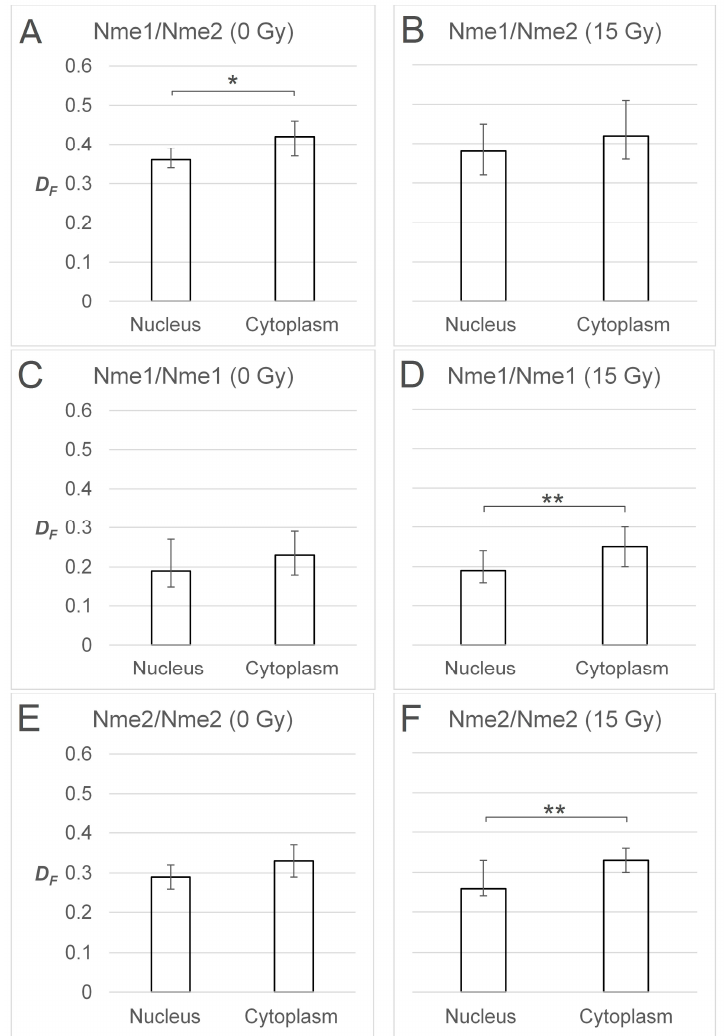
Figure 4. Comparison of D F between the nucleus and the cytoplasm in non-irradiated and irradiated cells expressing three pairs of fluorescently labeled NME proteins. Transfected cells were not irradiated (0 Gy) or irradiated with gamma radiation (15 Gy). ( A,B ) Comparison of D F between the nucleus and the cytoplasm in non ‐ irradiated ( A ) and irradiated ( B ) cells expressing EGFP ‐ NME1 and mCherry ‐ NME2. ( C,D ) Comparison of D F between the nucleus and the cytoplasm in non ‐ irradiated ( C ) and irradiated ( D ) cells expressing EGFP ‐ NME1 and mCherry ‐ NME1. ( E,F ) Comparison of D F between the nucleus and the cytoplasm in non ‐ irradiated ( E ) and irradiated ( F ) cells expressing EGFP ‐ NME2 and mCherry ‐ NME2. D F is shown as the median and the interquartile range. Statistical analysis shows that differences of D F between the nucleus and the cytoplasm ( A,D,F ) are statistically significant. *: p ≤ 0.05, **: p ≤ 0.01.